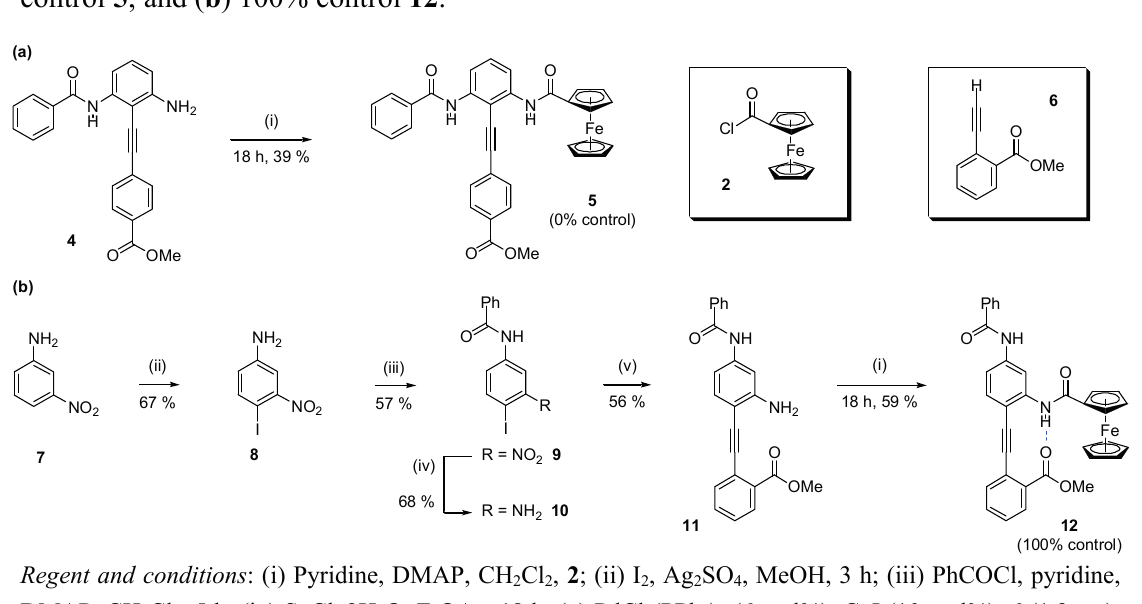
Scheme 2. Synthesis of benzamido/FcA-substituted diphenylacetylene compounds: ( a ) 0% control 5 ; and ( b ) 100% control 12 .